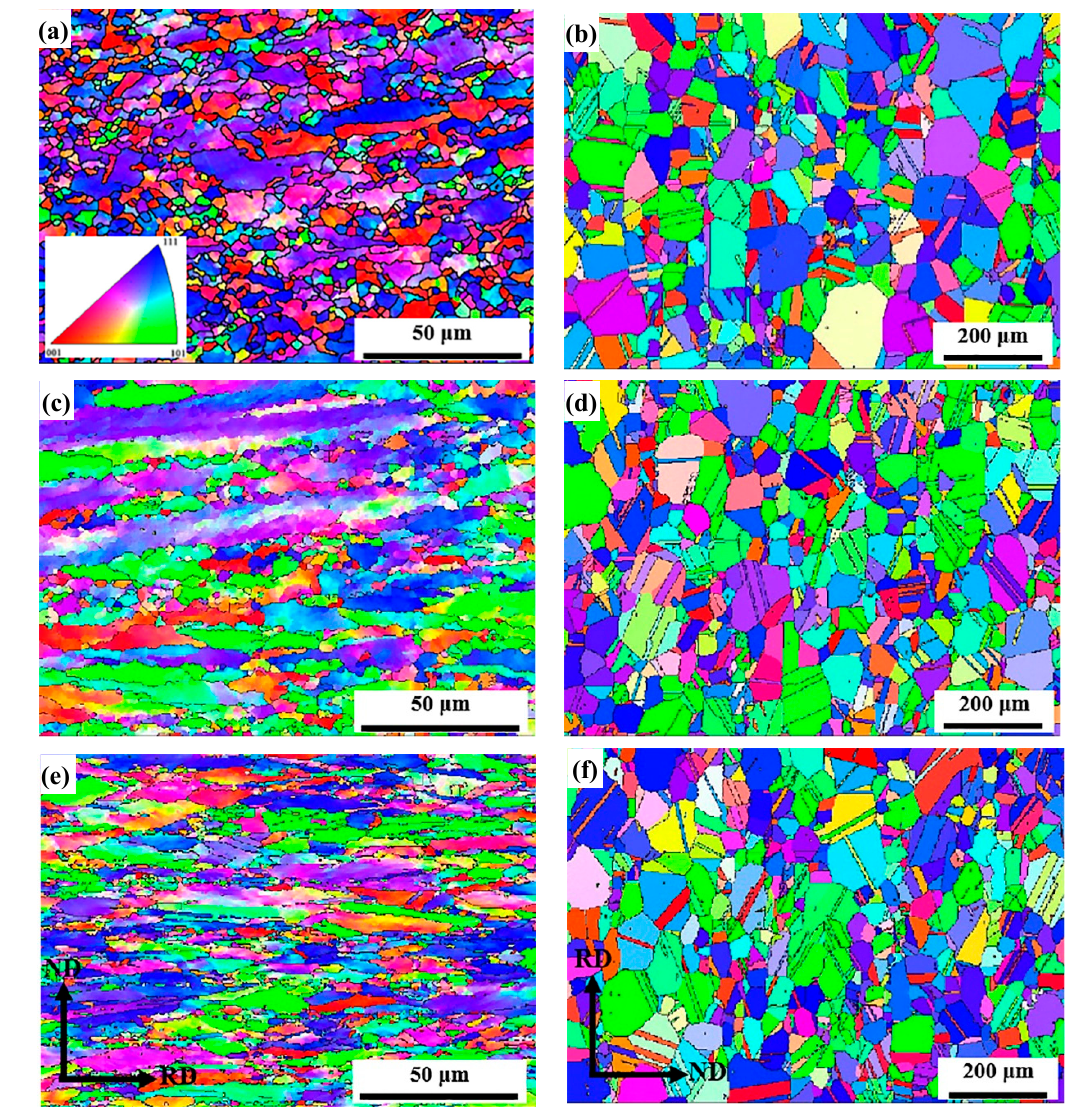
Figure 2. Orientation imaging maps of the AFA steel. ( a ), ( c ), ( e ) represent cold-rolled samples with reductions of 5%, 10%, 30%, and ( b ), ( d ), ( f ) represent the corresponding annealed samples after cold rolling, respectively. Table 2. Fraction of various grain types in cold-rolled samples (5%, 10% and 30%) and annealed samples (%).